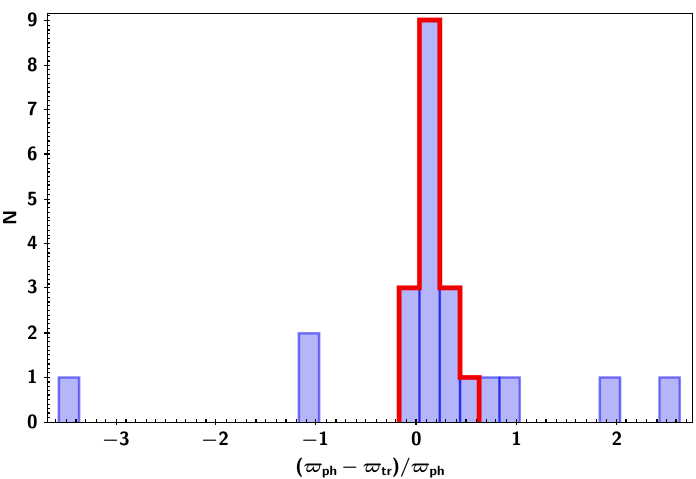
Figure 5. Distribution of stars used in Paper18 for the A V ( d ) construction by the ratio between the difference in parallax (cid:118) ph − (cid:118) tr and the photometric parallax (cid:118) ph . Subsample, designated by the red contour, does not include stars 21, 23 (red giants), 1, 2, 2 (possible sub-dwarfs) and 18, 20 (apparently supergiants), discussed in the